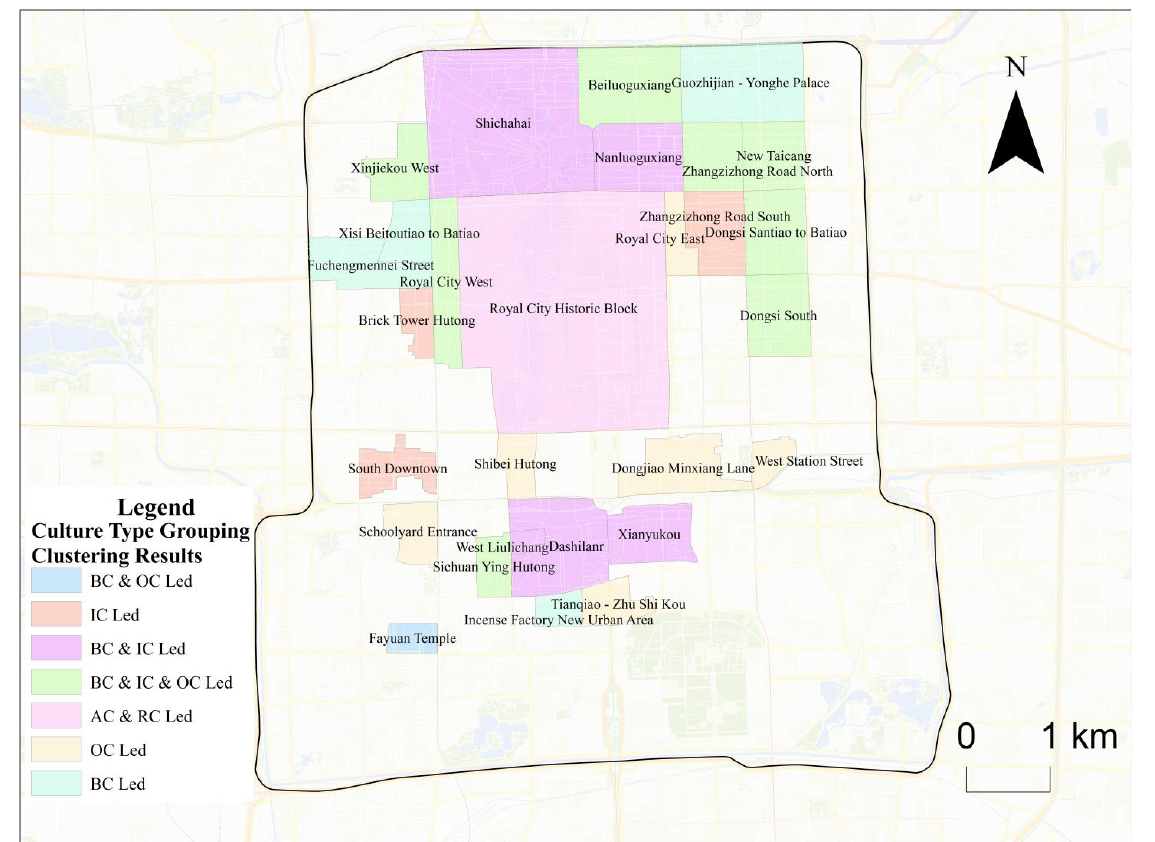
Figure 6. Clustering results of cultural types grouped in 28 historical and cultural blocks in the old city of Beijing. Based on the optimal assessment of the ArcGIS grouping analysis, the 28 historic and cultural blocks were divided into seven groups (Figure 6), and the classification characteristics of each group are shown in Table 3. Table 3. Grouping clustering characteristics.